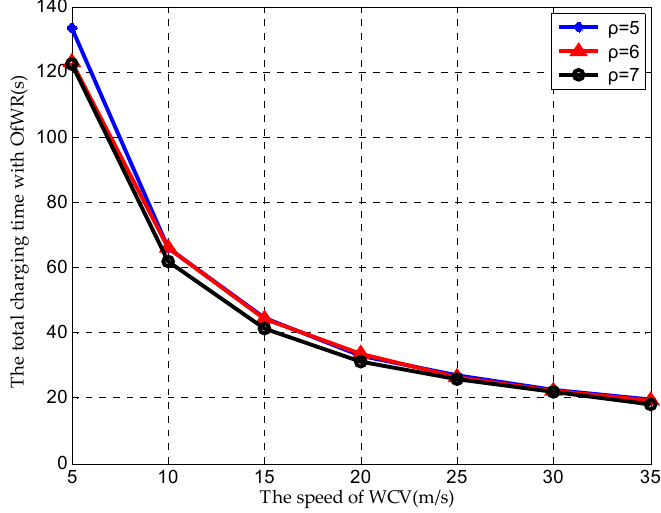
Figure 11. The total charging time varying with the speed of WCV.